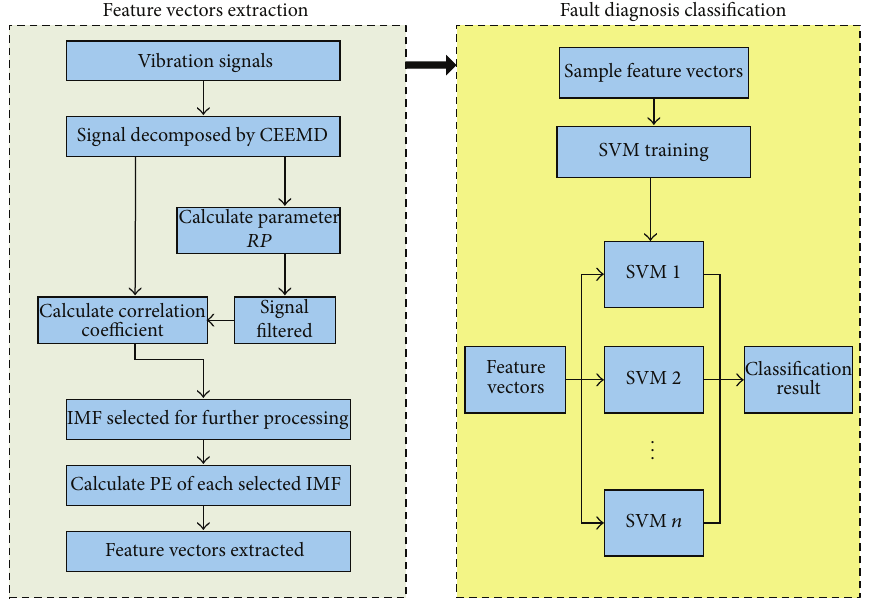
Figure 5: Flow chart of the proposed